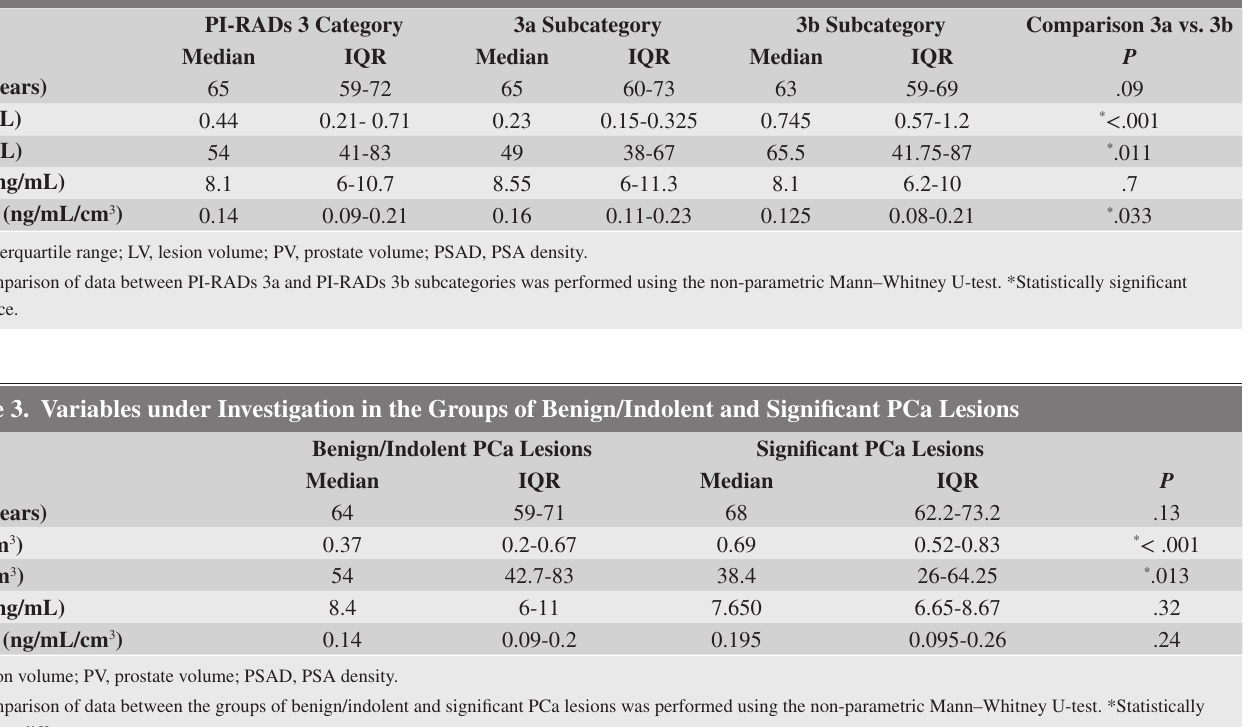
Table 2. Variables under Investigation in PI-RADS 3 Category and Subcategories